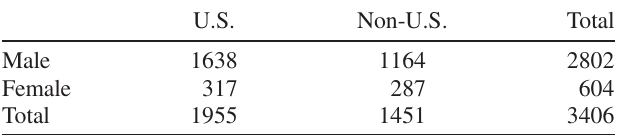
TABLE I. Demographic breakdown of the data used in this analysis. To focus on issues of diversity and inclusion most strongly associated with U.S. applicants to physics graduate programs, we analyze only the data from U.S. graduate